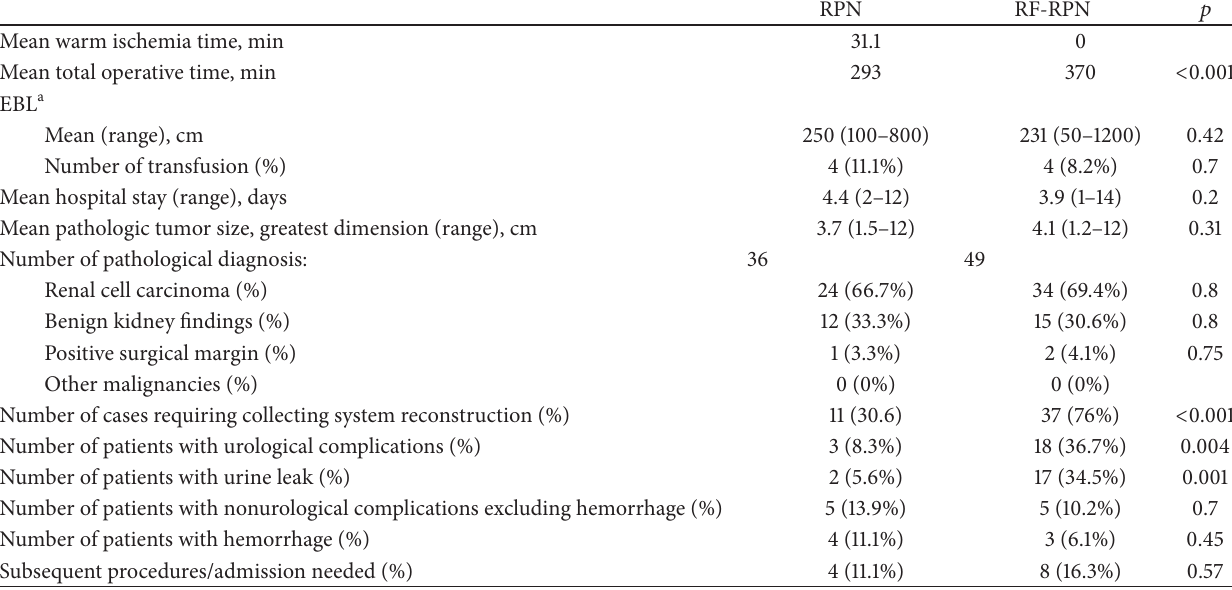
Table 2: Perioperative outcomes and